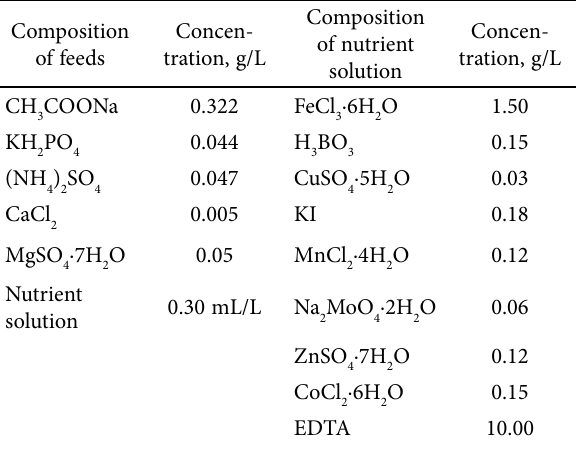
Table 1. Composition of synthetic wastewater used in this study.